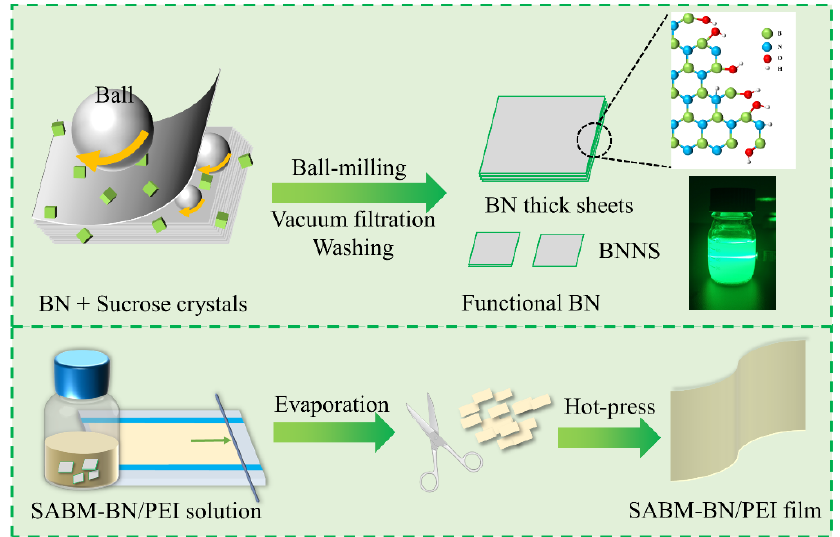
Figure 1. Schematic diagram illustrating the preparation of the SABM-BN and composite